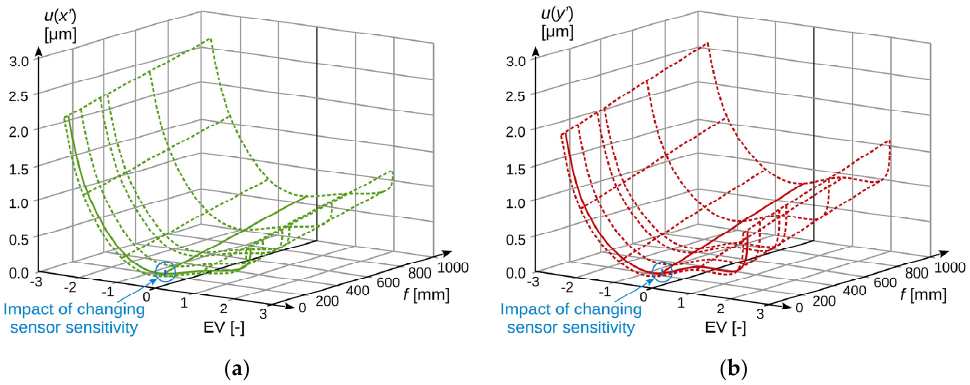
Figure 9. Standard uncertainty of measuring the position of the object image on the camera sensor as a function of changes in the acquisition image brightness and lens focal length: ( a ) measurement uncertainty in horizontal axis x ; ( b ) measurement uncertainty in vertical axis y.